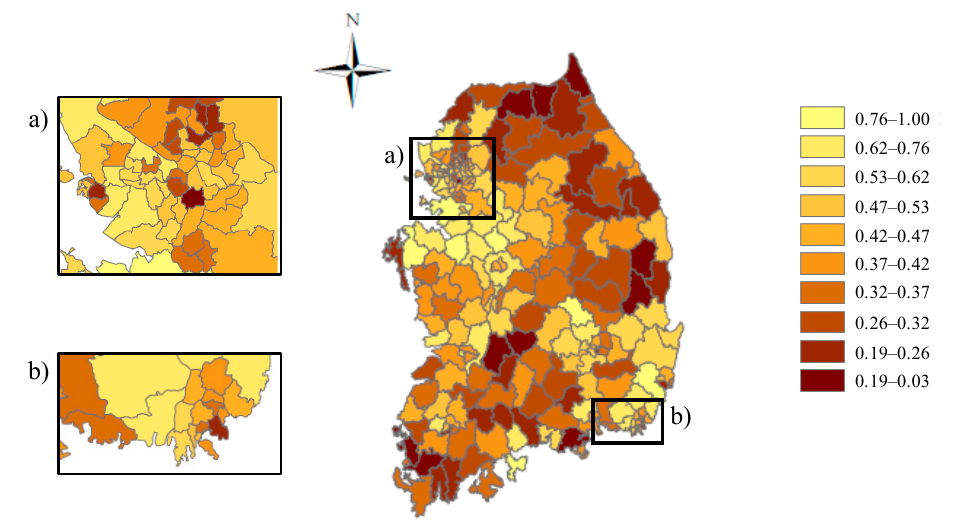
Figure 4. Weighted entropy of cities and counties in South Korea (illustrated with ArcMap TM 10 [53]): ( a ) the capital, Seoul, and vicinity; and ( b ) the second metropolitan area, Busan, and vicinity.